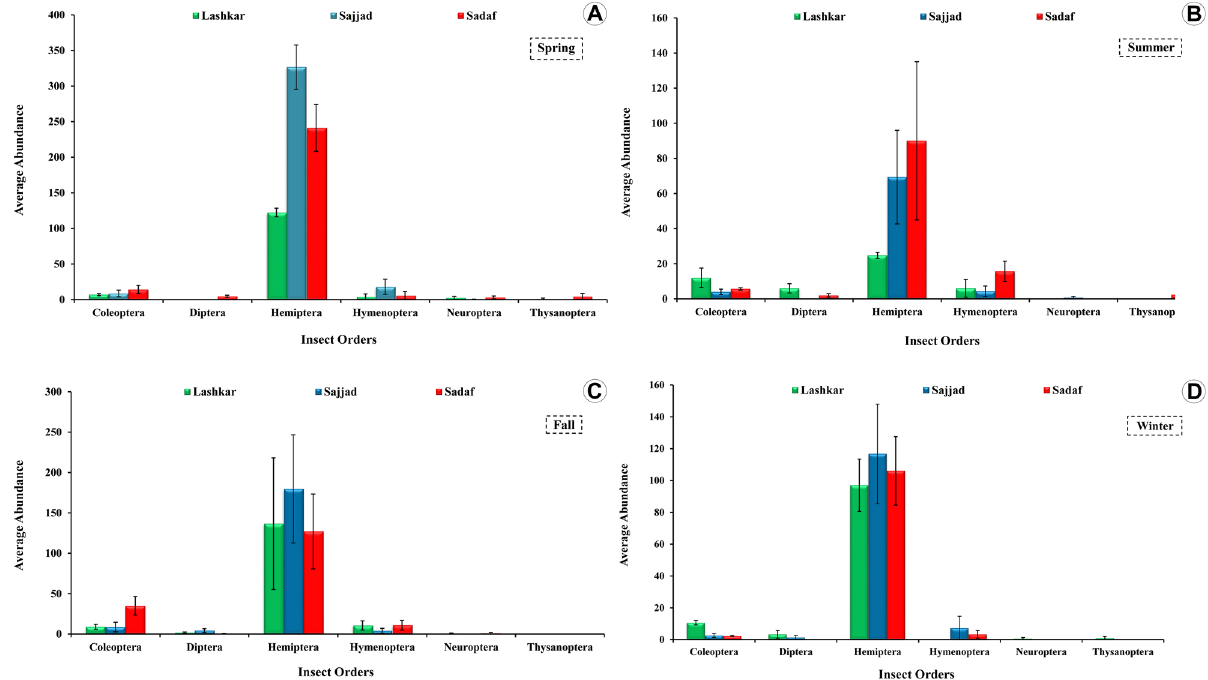
Figure 1. Species abundance of insect orders associated with the Chinese thuja trees, Platycladus orientalis (L.) during the four seasons in three urban green spaces in Mashhad, Iran. ( A ) Spring. ( B ) Summer. ( C ) Fall. ( D ) Winter.